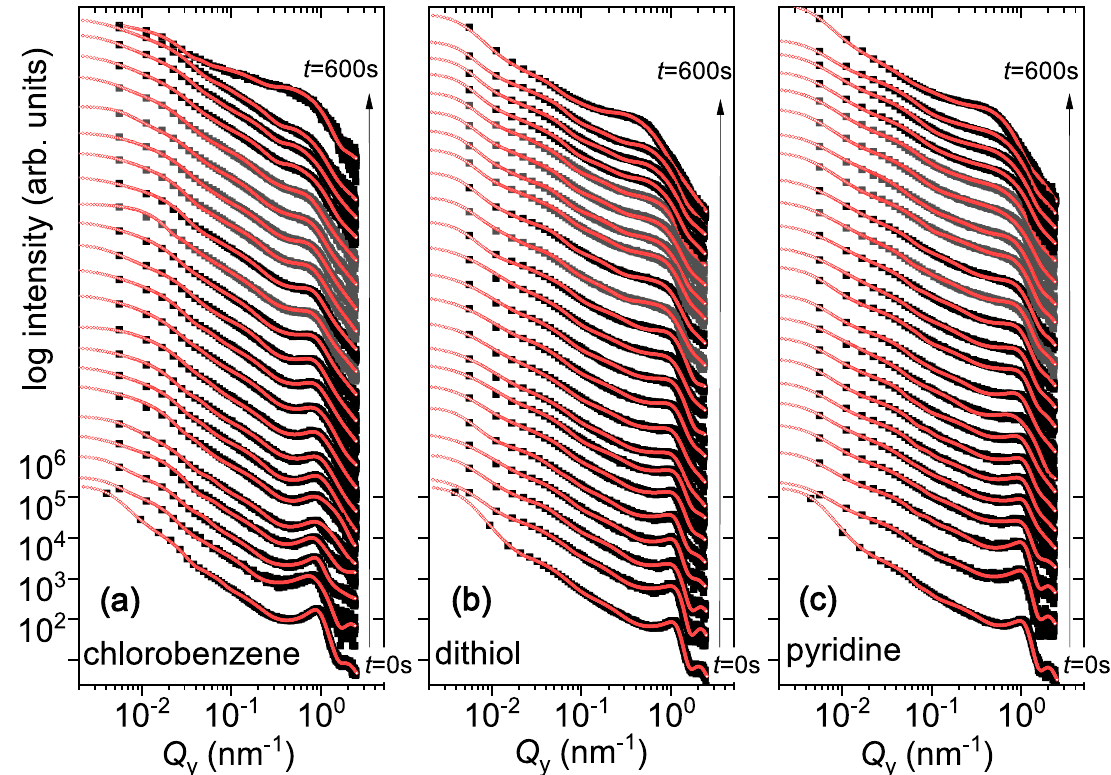
Figure 6. QDs prepared with ( a ) chlorobenzene , ( b ) dithiol and ( c ) pyridine solvents. Horizontal line cuts from the 2D GISAXS data along Q y at different Q z values along with their fits (red lines). They are plotted for different Au thicknesses from d Au = 0 nm to 14.4 nm (from bottom to